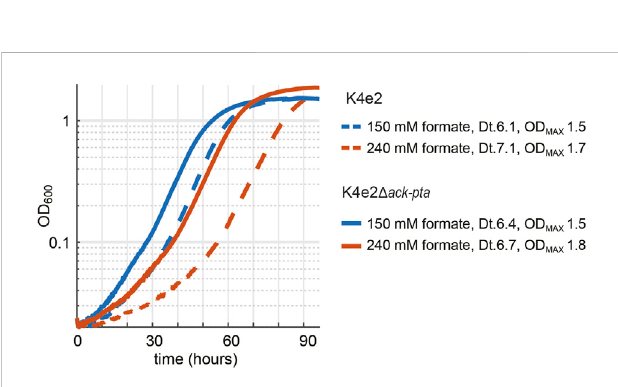
FIGURE 4 Deletion of ack-pta in K4e2 further optimizes formatotrophic growth. Experiments were carried out at 10% CO 2 in 96-well plates in triplicates, displayed results are averages with errors <